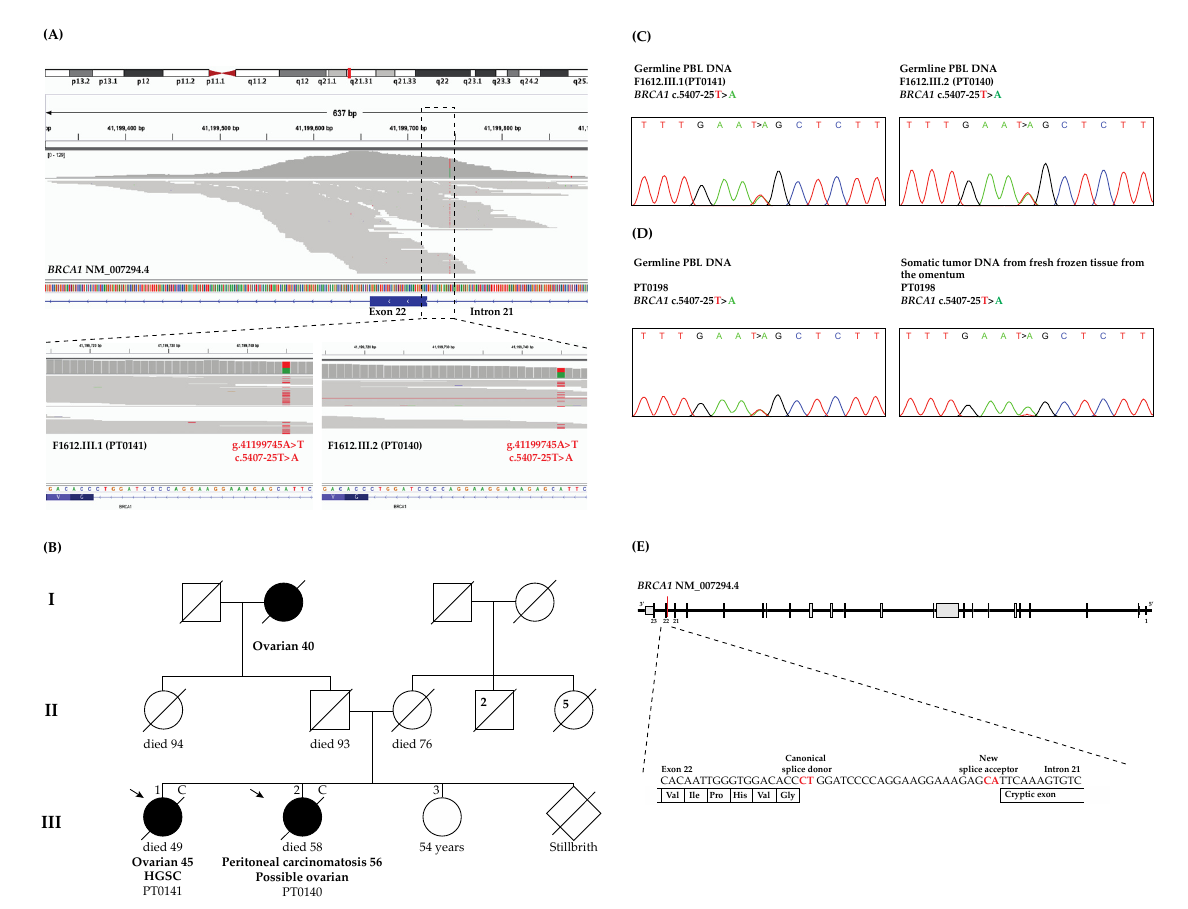
Figure 1. Identification of BRCA1 c.5407-25T>A, a likely pathogenic intronic variant. ( A ) Integrative Genomics Viewer (IGV) v2.8 sequencing data showing coverage of exon 23 of BRCA1 and flanking intronic regions beyond ±20 nucleotides of location of BRCA1 c.5407-25T>A in variant carriers; ( B ) pedigree of BRCA1 c.5407-25T>A carrier family (F1612) indicating confirmed (“C”) cases of bilateral high-grade serous carcinoma (HGSC) (PT0141) and primary peritoneal carcinomatosis with possible ovarian origin (PT0140) by pathology reports; ( C ) sequencing chromatogram of peripheral blood lymphocytes (PBL) DNA verifying heterozygous carrier status of both sisters; and ( D ) sequencing chromatograms from a sporadic early-onset OC case (PT0198) verifying heterozygous BRCA1 variant carrier status in PBL DNA and loss of the wild-type allele in OC tumor DNA; ( E) Schema illustrating the location of the intronic BRCA1 variant creating a new splice site as predicted by SpliceAI.